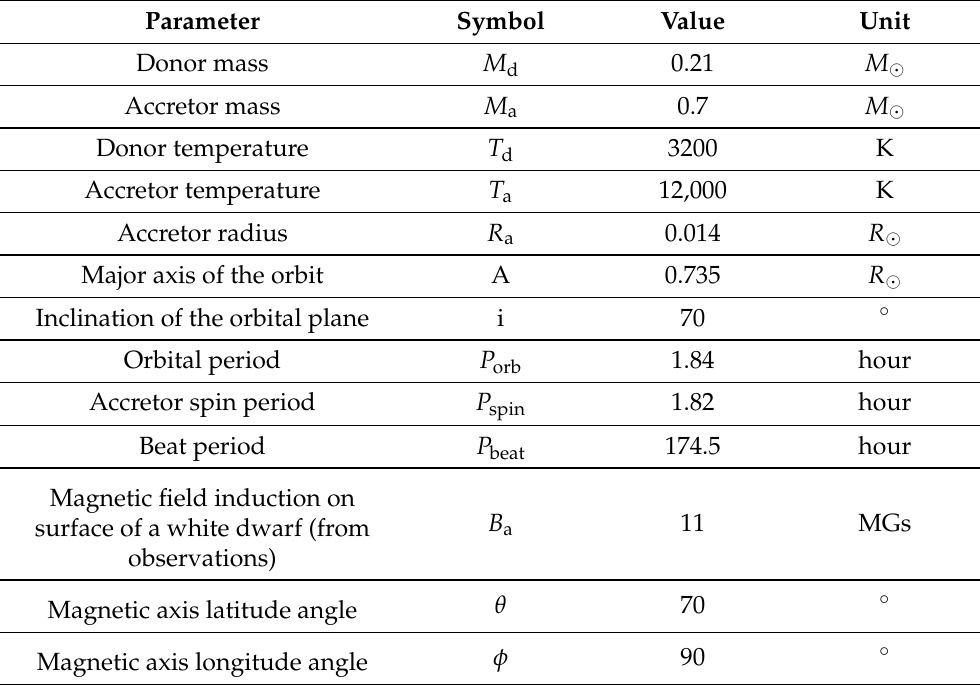
Table 2. Initial parameters for calculations of the asynchronous polar CD